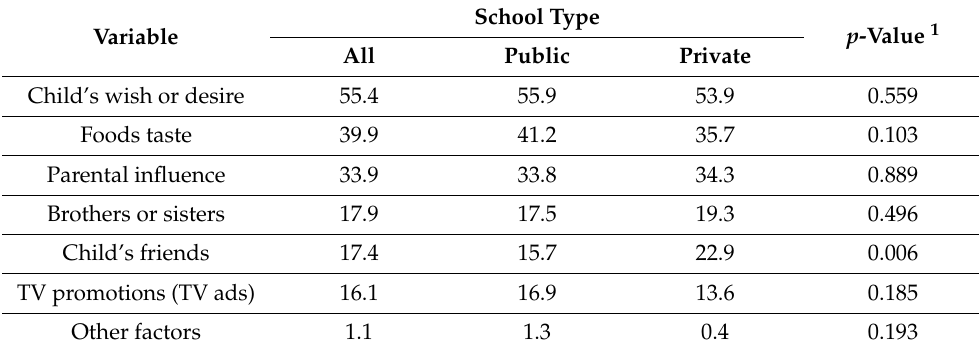
Table 5. Factors influencing breakfast choices by Saudi children relative to school type (more than one choice was